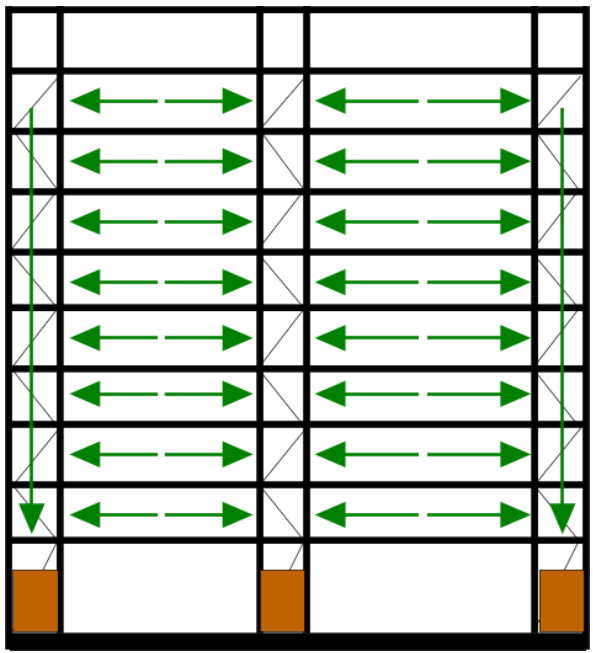
Figure 3: Evacuation plan from multiple floor